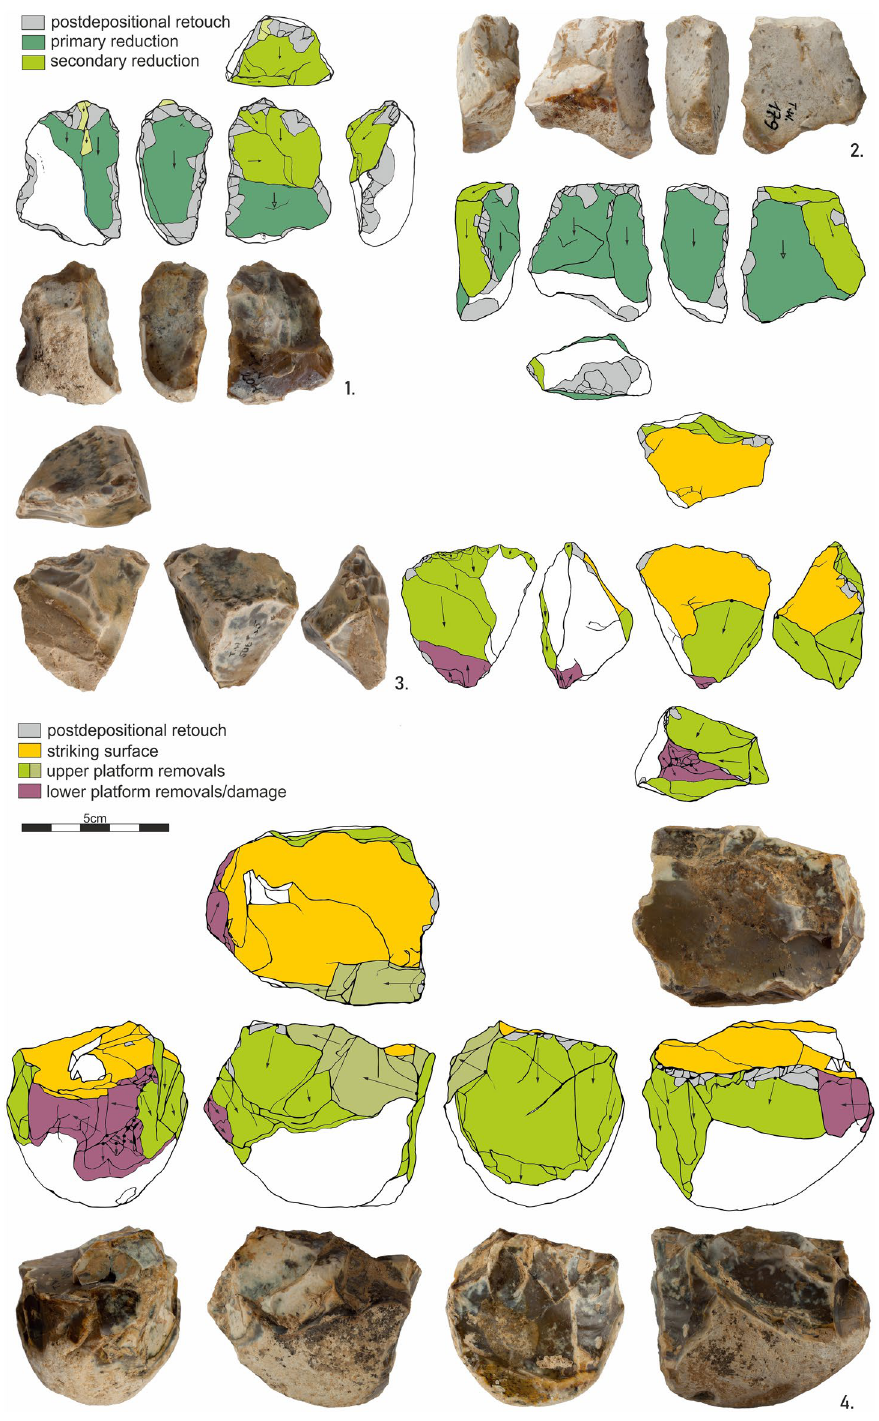
Figure 5. Tunel Wielki Cave. 1–2. Cores on flakes; 3–4. Cores made on flint nodules, with visible lower platform removals and